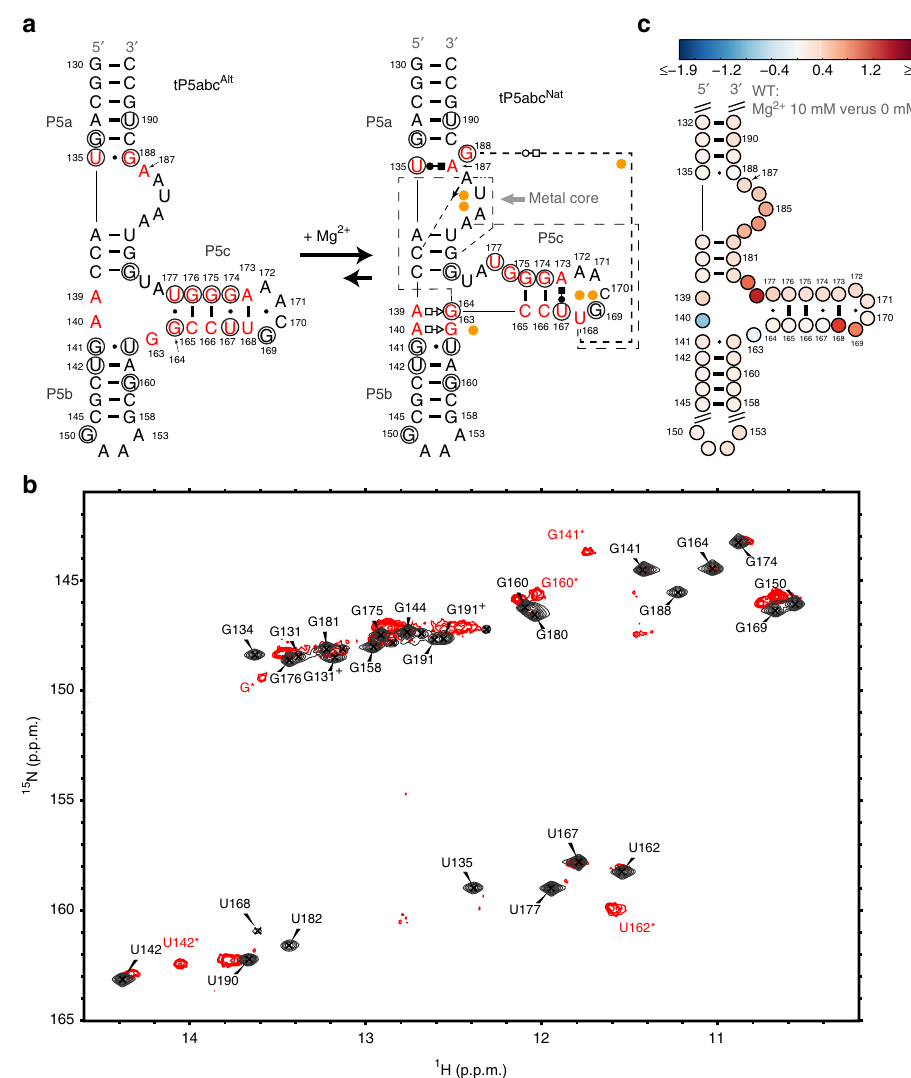
Figure 1 | NMR and SHAPE analysis of tP5abc. ( a ) Structure of tP5abc with and without Mg 2 þ . Magnesium ions identified in the X-ray structure (PDB ID: 1GID) are represented as orange spheres. Non-Watson–Crick base pairs in tP5abc Nat are represented by Leontis/Westhof symbols 66 . Five base pairs are removed from P5b relative to the natural sequence. Tertiary interactions are indicated using dashed lines: U168 stacks on A183; A186 forms H-bonds with G181, C137 and G164. Residues undergoing change in secondary structure are shown in red. Residues with imino resonances that undergo changes or disappear on addition of Mg 2 þ are circled in black. ( b ) Overlay of 2D 1 H- 15 N HSQC spectra of 1mM tP5abc in the absence of Mg 2 þ (black) and 0.1mM tP5abc in the presence of 7.5mM Mg 2 þ (red) in 10mM sodium phosphate and 0.01mM EDTA, pH 6.4, at 10 (cid:2) C. MgCl 2 was directly added to the NMR sample. Resonances belonging to tP5abc Nat are labelled with asterisks based on the previous assignments 26 . The resonances labelled with ‘ þ ’ represent alternative states for residues G131 and G191 due to minor N þ 1 transcripts. ( c ) Differential SHAPE reactivity of 0.2 m M WT P5abc in the presence of 10mM Mg 2 þ relative to no Mg 2 þ conducted in 10mM sodium phosphate and 0.01mM EDTA, pH 6.4, at 10 (cid:2) C. Red (blue) represents more (less) reactivity of one state relative to the other. The extended P5abc construct is shown in Supplementary Fig. 2a.